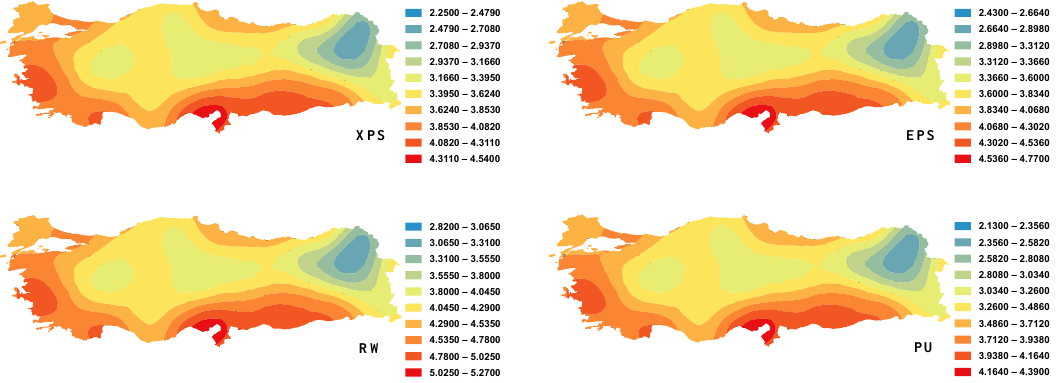
Figure 8. Spatial maps of energy savings in all climate zones of Türkiye at −2 0 °C reference temperature for four insulation materials (each of the maps has its own legend).